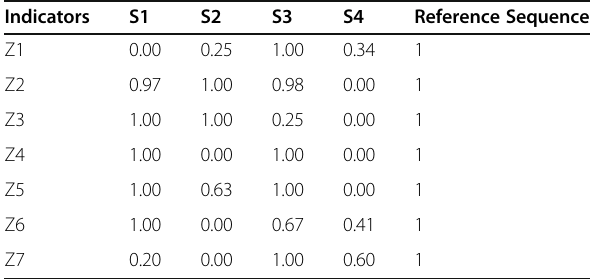
Table 15 Weight of Each Evaluation Indicator (Source: